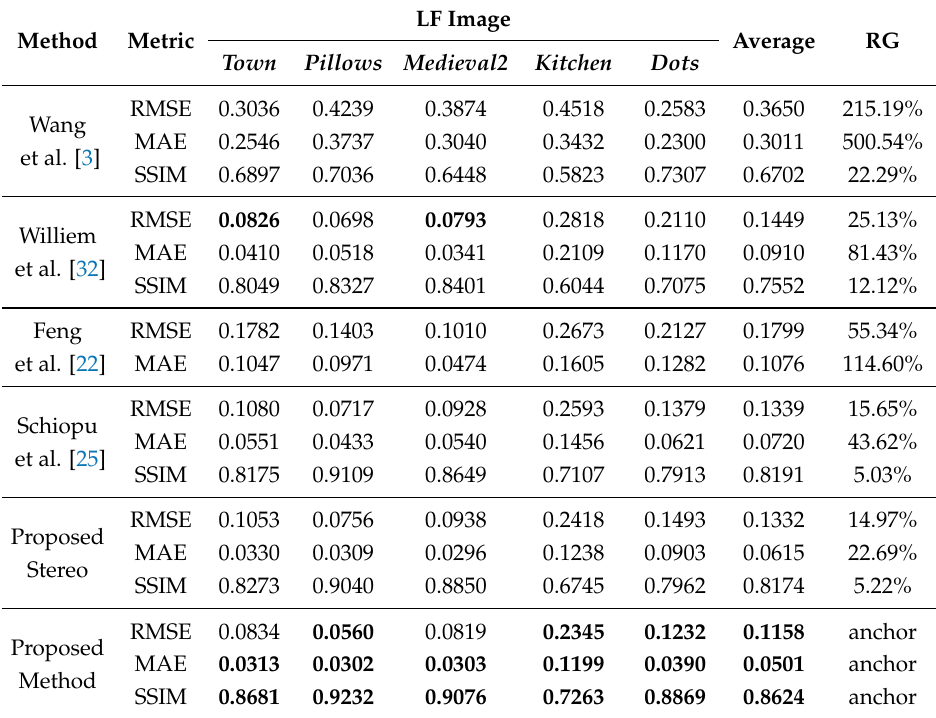
Table 1. Qualitative comparison in RMSE, MAE, and SSIM between computed and ground truth disparity maps for the training configuration of